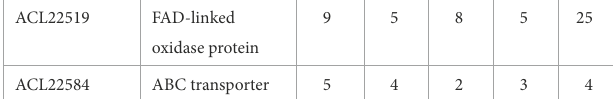
TABLE 1 Proteins significantly up-regulated in fermentative conditions (Py-only) vs. all respiratory conditions. Accession Predicted Fold-change in Py-only function